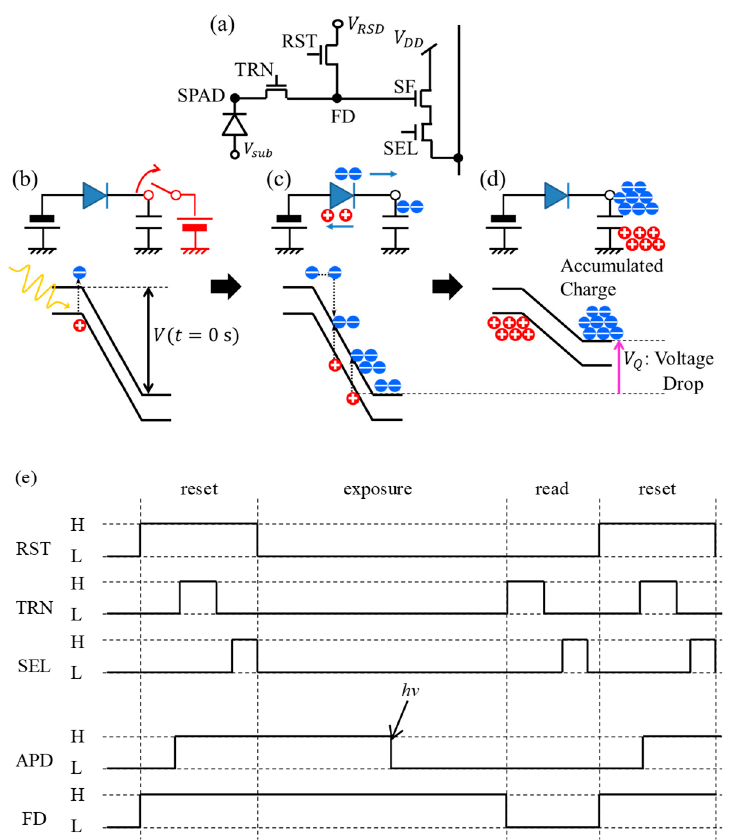
Figure 1. ( a ) Circuit diagram of a four transistors pixel circuit. Abbreviations TRN, RST, FD, SF, and